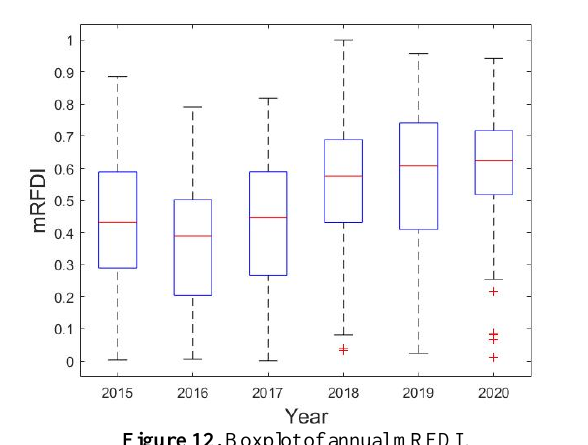
Figure 12. Boxplot of annual